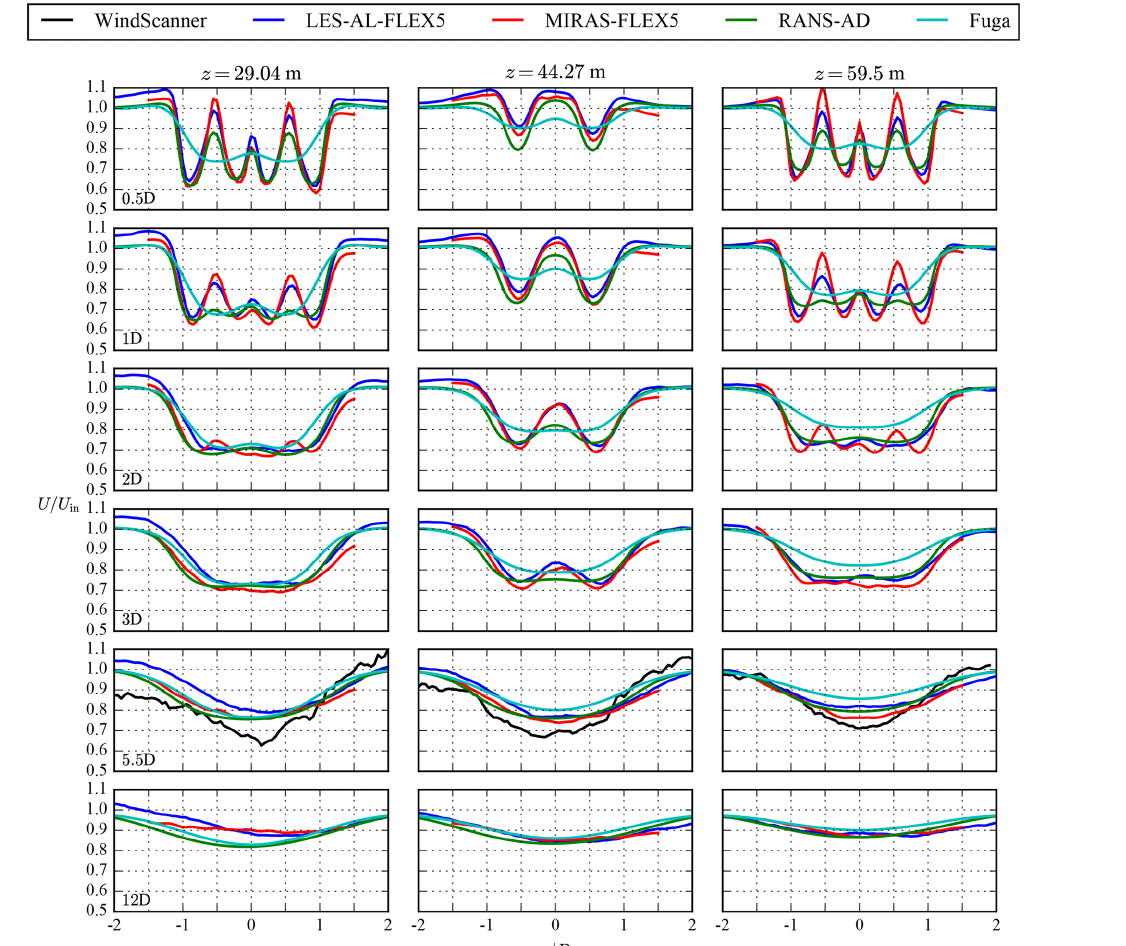
Figure 16. Far-wake case: profiles of stream-wise velocity at three heights and six downstream